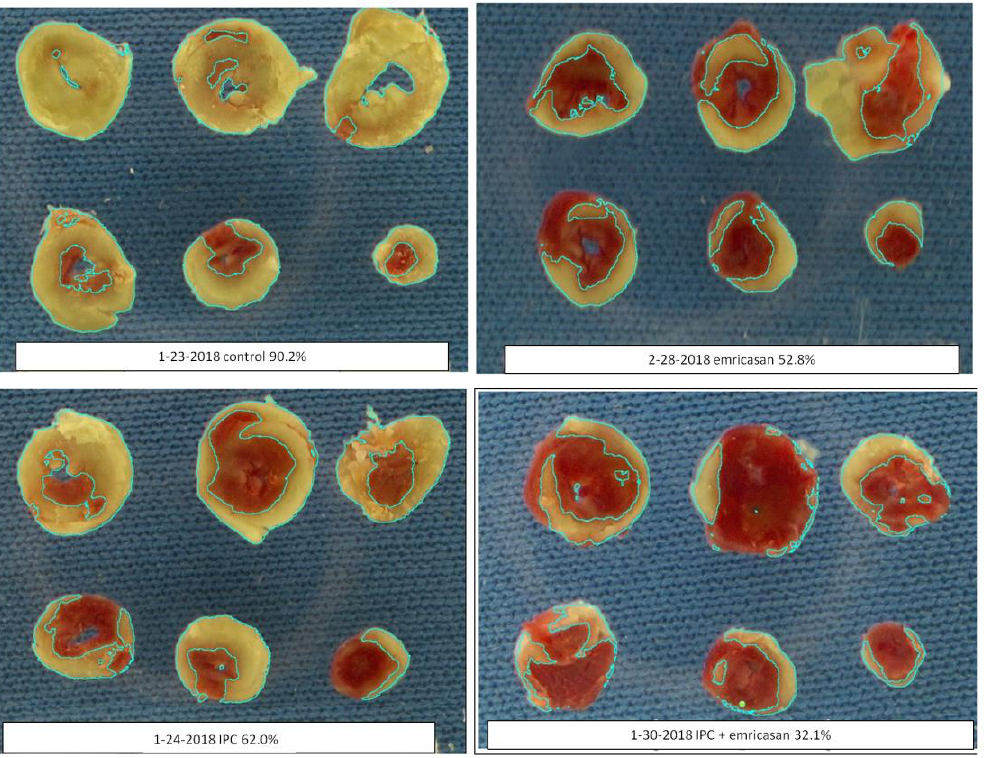
Figure 4. Representative examples of four typical hearts from protocol I (see below) analyzed by ImageJ. The six slices from the heart are stained with tetrazolium. The infarct (pale area) is outlined with a line as drawn by ImageJ’s color threshold function. The same threshold settings were used for all hearts. The white paper strip at the bottom of each panel is a 2 cm long scale bar.